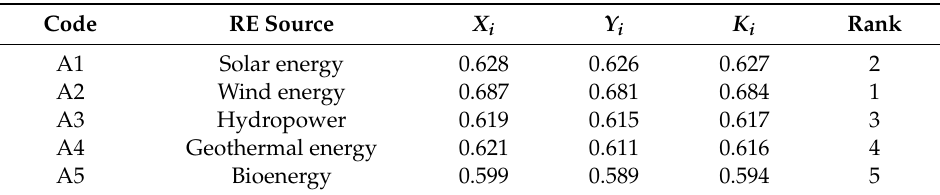
Table 9. X i , Y i , and K i values of RE sources. Table 9. (cid:1850) (cid:3036) , (cid:1851) (cid:3036) , and (cid:1837) (cid:3036) values of RE sources.